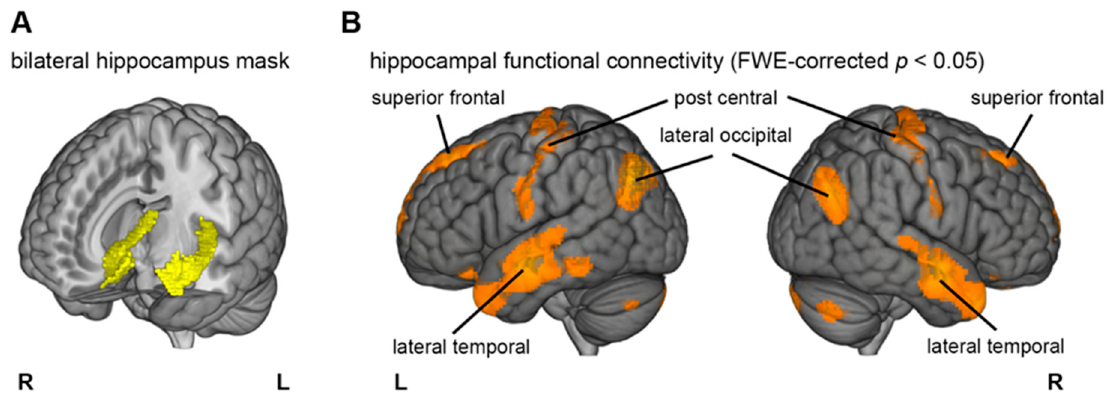
Figure 1. ( A ) Illustration of the hippocampal mask that was used as the seed region. ( B ) Significantly connected regions located on the surface of the cortex.